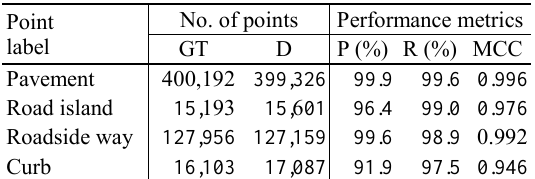
Table 2. Road surface extraction results for Experiment 2. Ground-truth; GT, and detected;